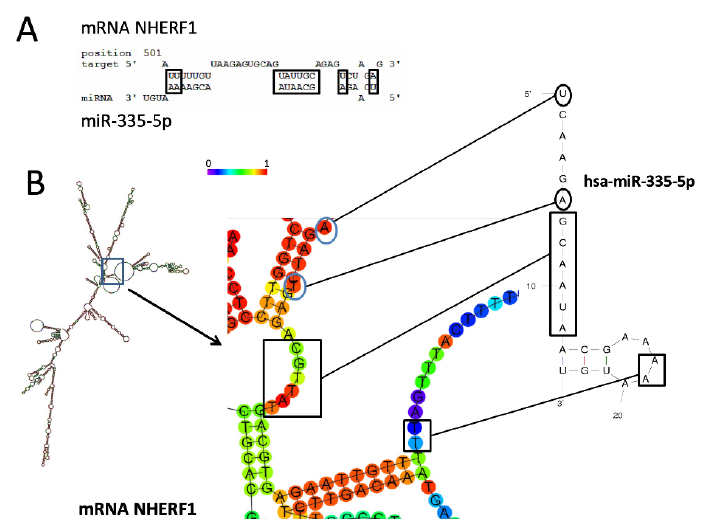
Figure 1. Computer-aided analysis of the possible pairing interaction between hsa-miR-335-5p (entry: http://www.mirbase.org/cgi-bin/mirna_entry.pl?acc=MI0000816) and NHERF1 mRNA (entry: https://www. ncbi.nlm.nih. gov/nuccore/381214354). The RNAhybrid tool for the predic- tion of miRNA and mRNA interaction (https://bibiserv2.cebitec.uni-bielefeld.de/rnahybrid) [47], the UNAfold web server (http://unafold.rna.albany.edu/), and the RNAfold WebServer (http://rna.tbi.univie.ac.at/cgi-bin/RNAWebSuite/RNAfold.cgi) were used. ( A ) Complementarity between miR-335-5p and NHERF1 mRNA miR-335 site; ( B ) magnification of the stem-loop second- ary structure indicating possible interactions. Colors in the schematic structure refer to probability of base pairing or unpairing (remaining as single base). Red segments contain the paired (or unpaired) bases of the highest probability.